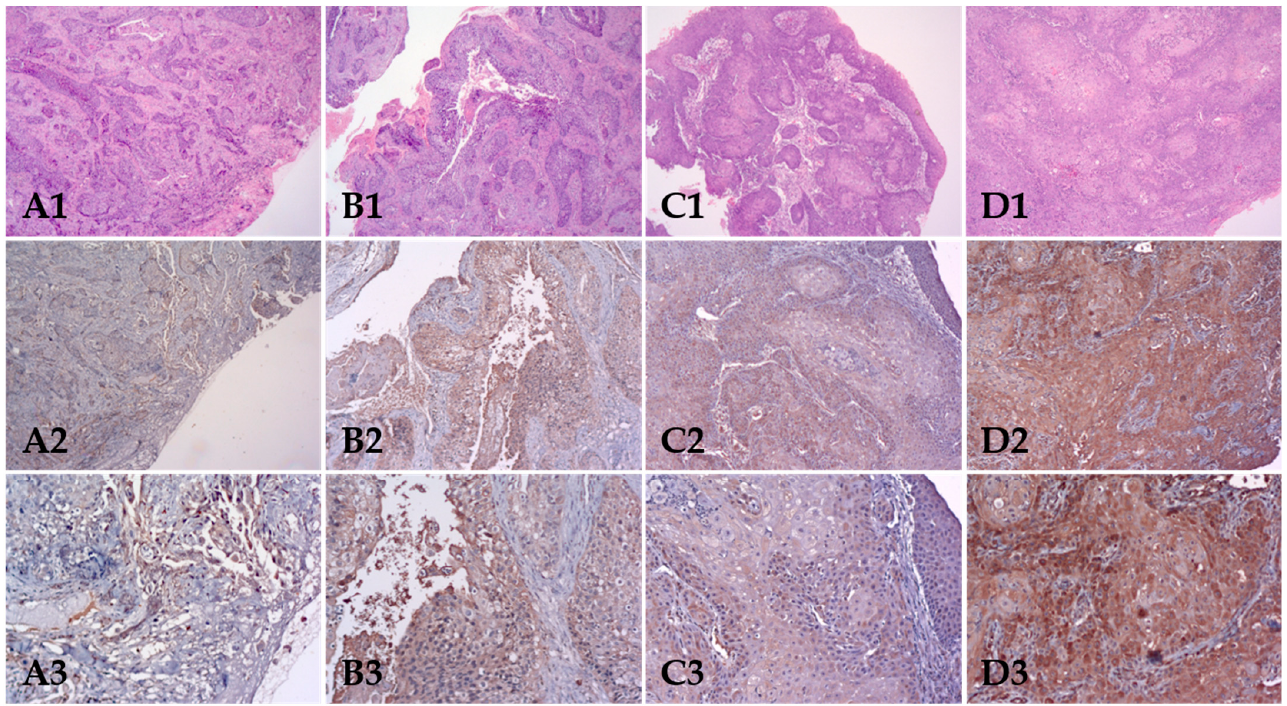
Figure 1. Immunohistochemical (IHC) staining of the p-mTOR in four cases of OSCC ( A – D ), showing low expression (extent and intensity) (case ( A2 , A3 )), high extent and low intensity ( B2 , B3 , C2 , C3 ) and high expression (extent and intensity) ( D2 , D3 ), ( B2 , B3 ). Numbers 1, 2 and 3 correspond to magnification at 5× (HE), 10× (IHC) and 20× (IHC), respectively.